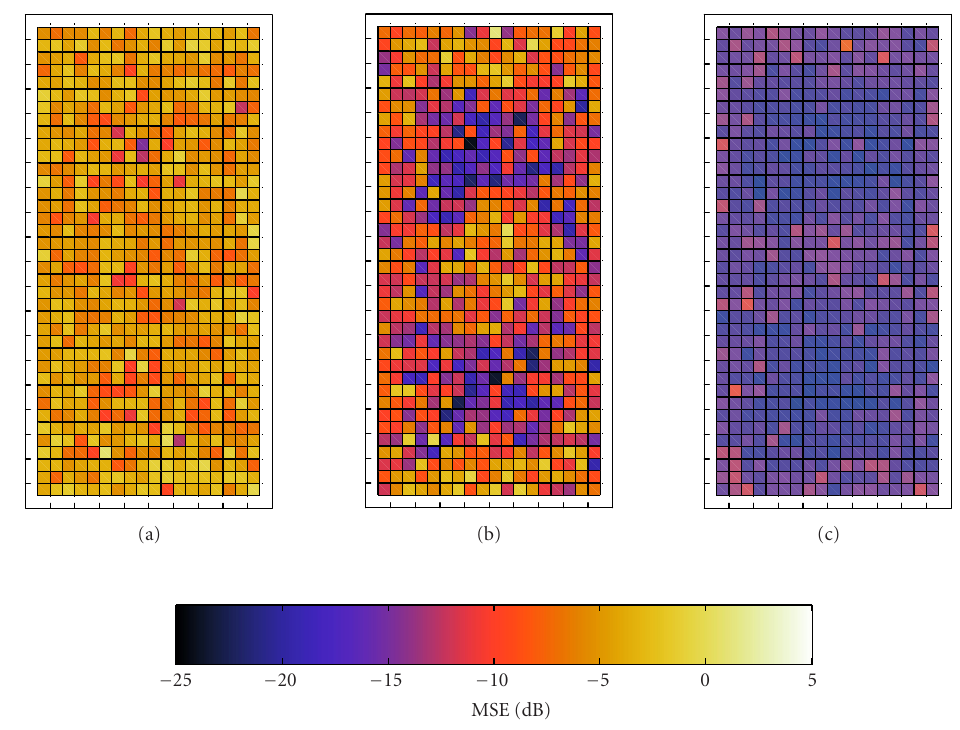
Figure 9: Average MSE of 32 subcarriers, averaged over 500 OFDM symbols, with 16-QAM modulation. (a) 1 element M = 6. (b) Fixed beamformer M = 6. (c) Adaptive beamformer M = 6.